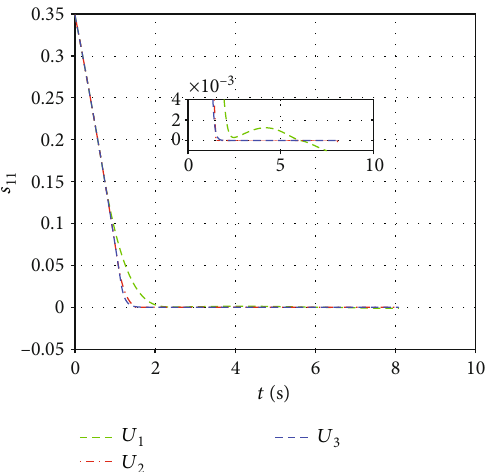
Figure 20: Target acceleration estimation in the lateral plane.